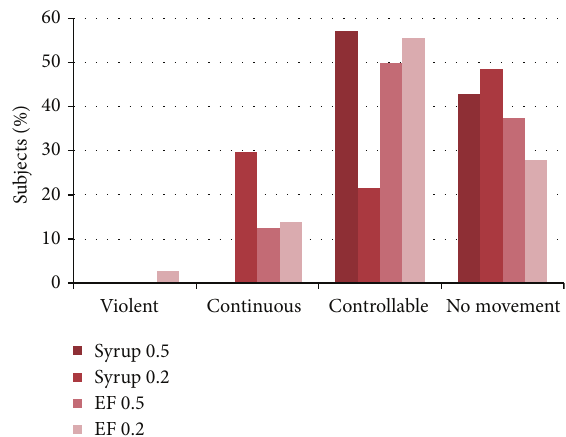
Figure 4: Percentage of subjects in each of Houpt categories of crying in two study groups adjusted for dose/age (dose 0.5 or 0.2 mg/kg).